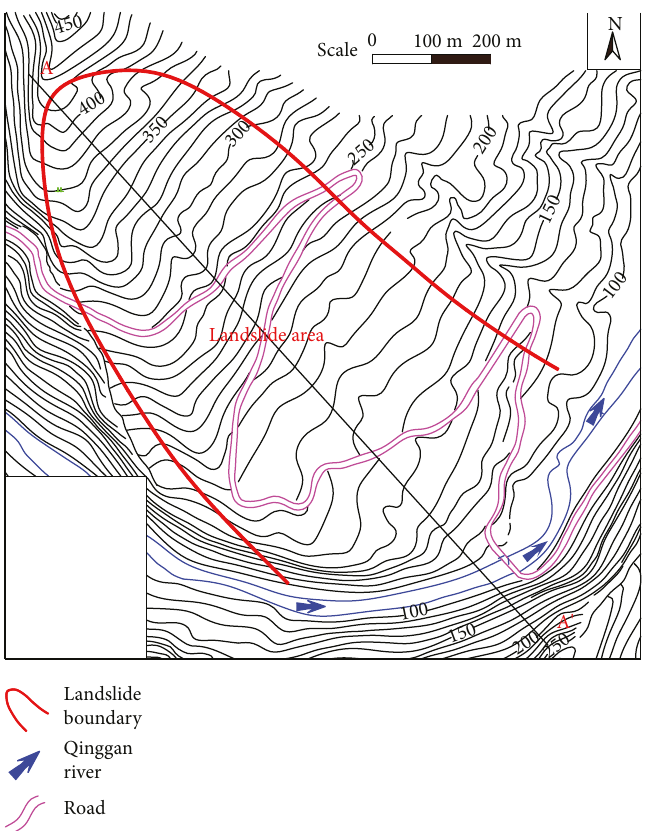
Figure 3: Topographical map of the Qianjiangping